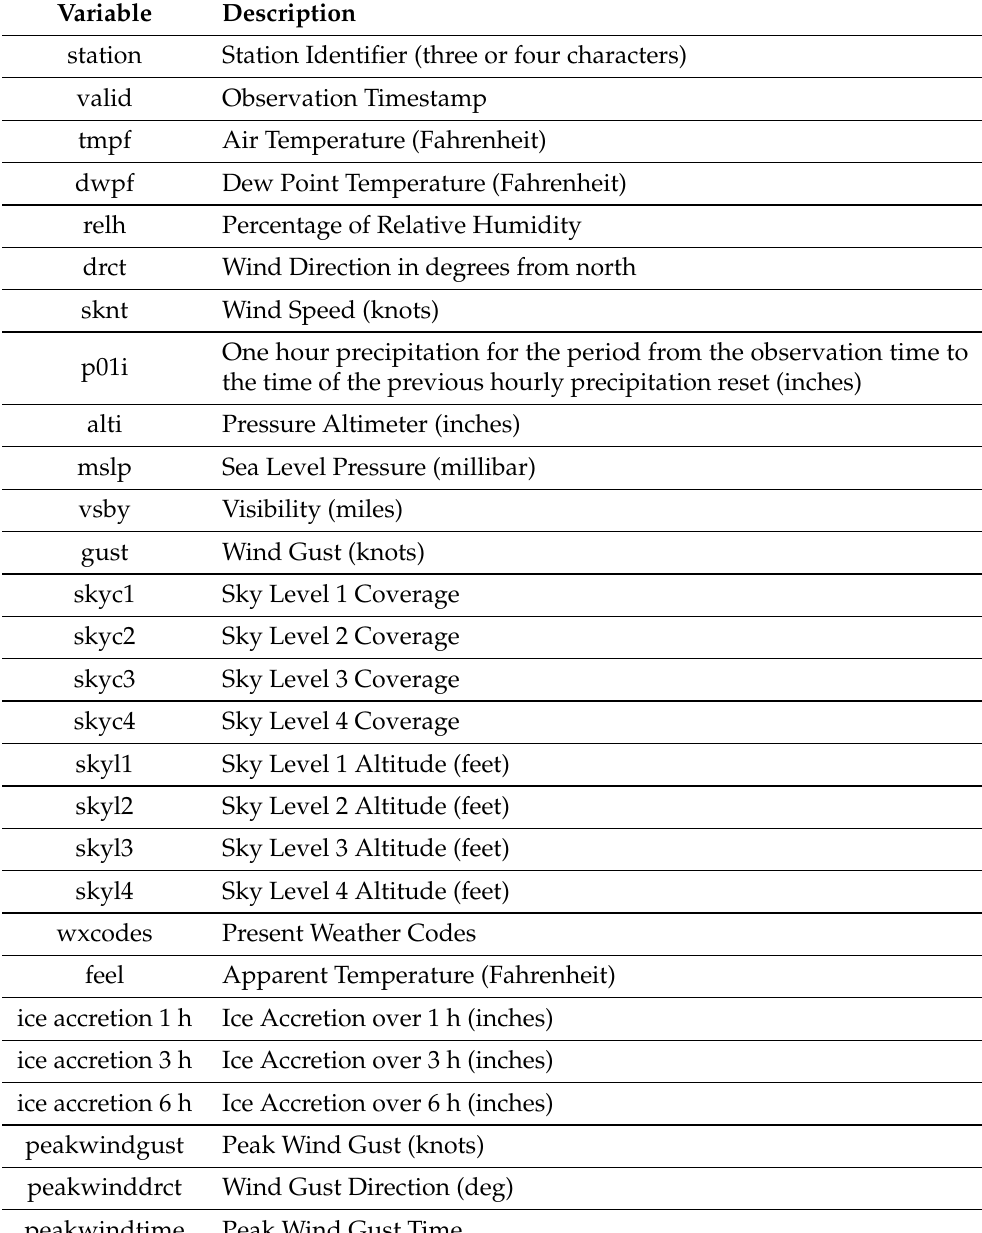
Table 2. Winter precipitation data